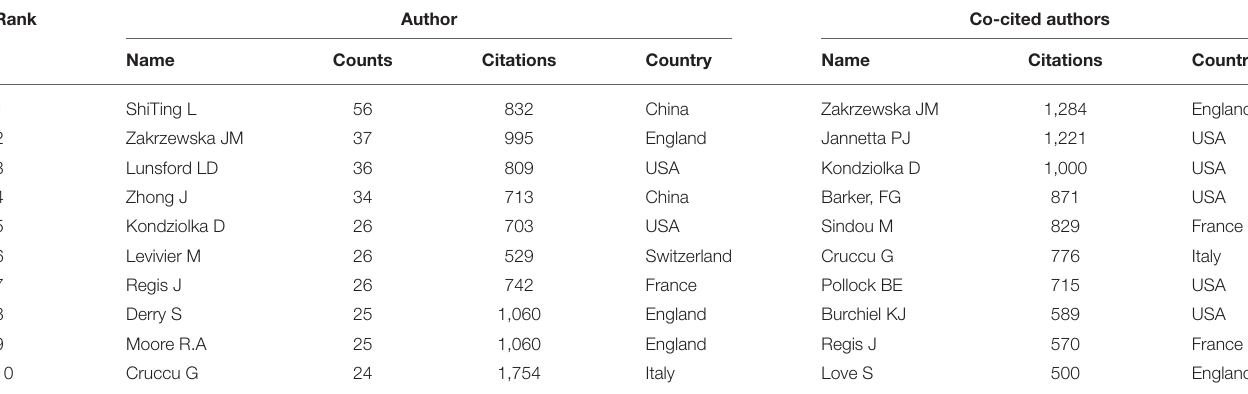
TABLE 2 | The top 10 prolific authors and co-cited authors on trigeminal neuralgia (TN) research from 2001 to 2021.